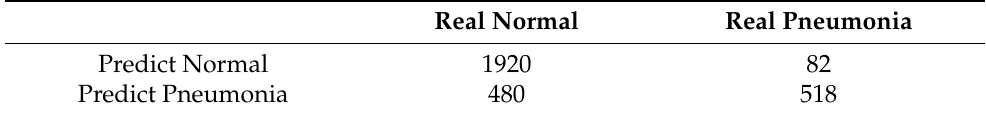
Table 14. Confusion matrix of native ViT on the synthetic-covid-cxr dataset.